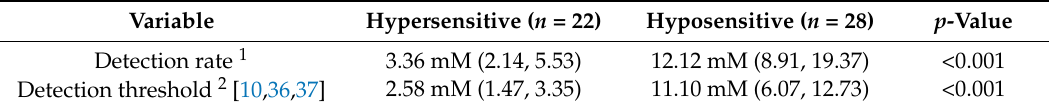
Table 3. Comparison of median (25th–75th percentiles) detection rate and detection threshold of hypersensitive and hyposensitive taste groups.